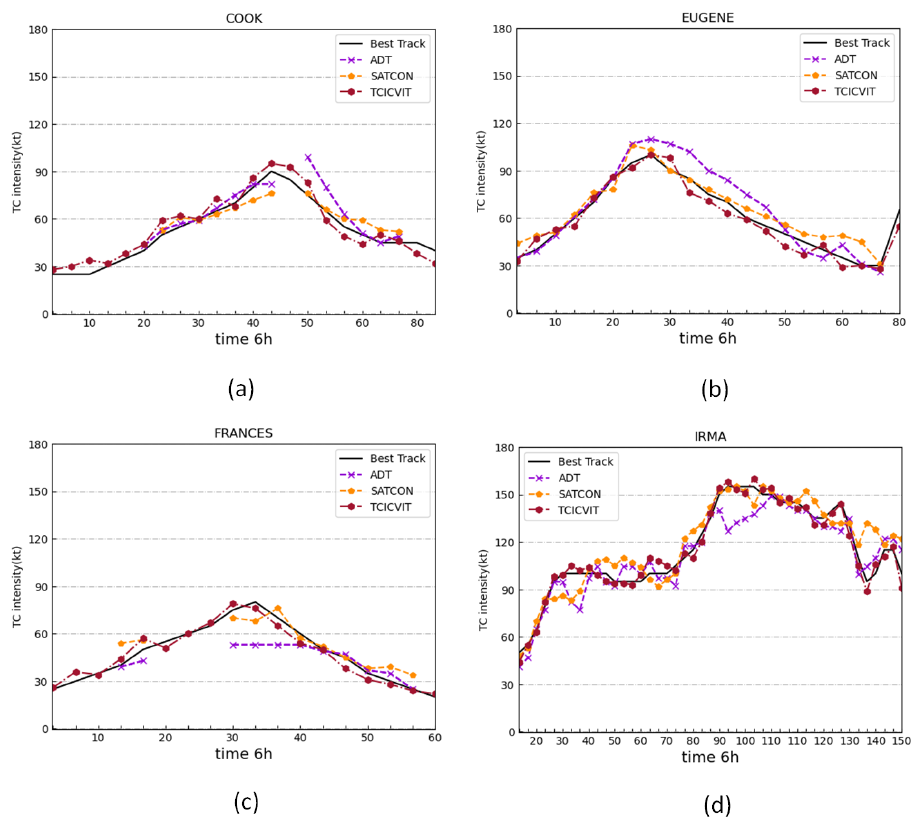
Figure 10. Comparison of TC intensity from best-track data and TCICVIT, ADT, and